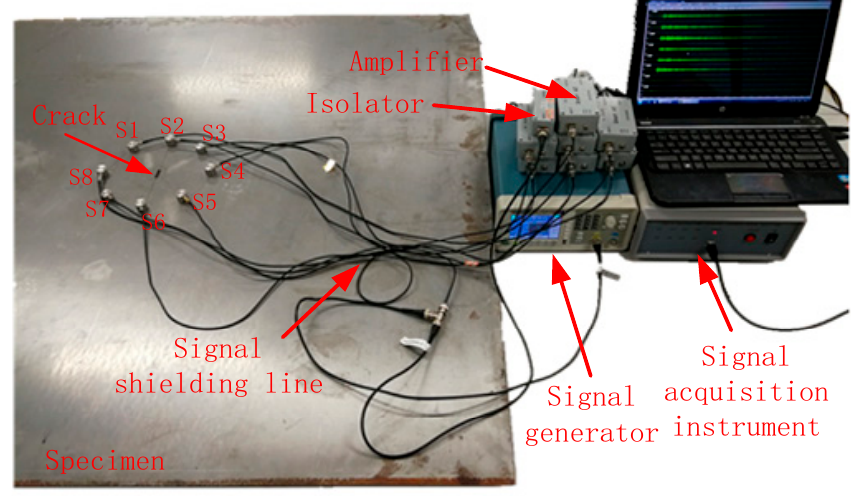
Figure 17. Experimental device schematic.